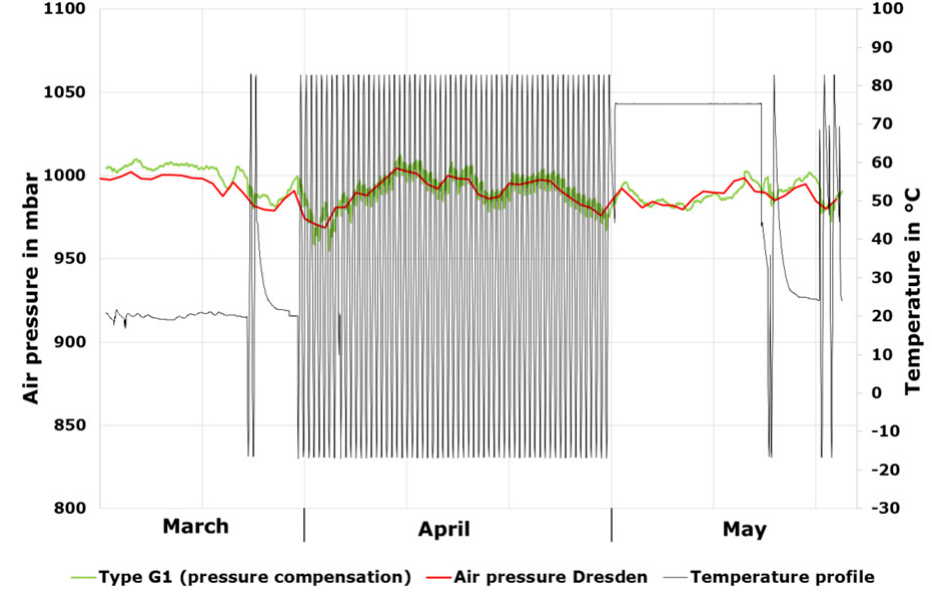
Fig. 10 Barometric and atmospheric pressure in an insulating glass unit with pressure